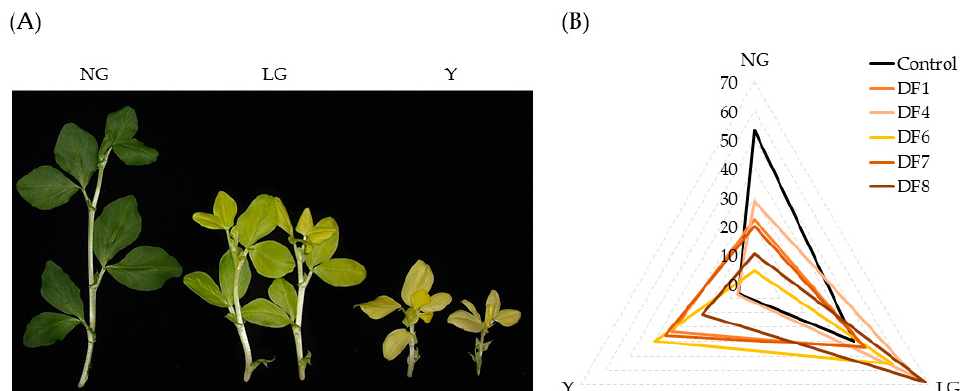
Figure 2. Phenotypic groups ( A ) and frequencies ( B ) of Co-induced chlorophyll morphoses (NG— normal green, LG—light green, Y—yellow) observed in V. faba plants grown in soil possessing different pollution levels. DF1,4,6,7,8—polluted soil from different sites of the drill factory.